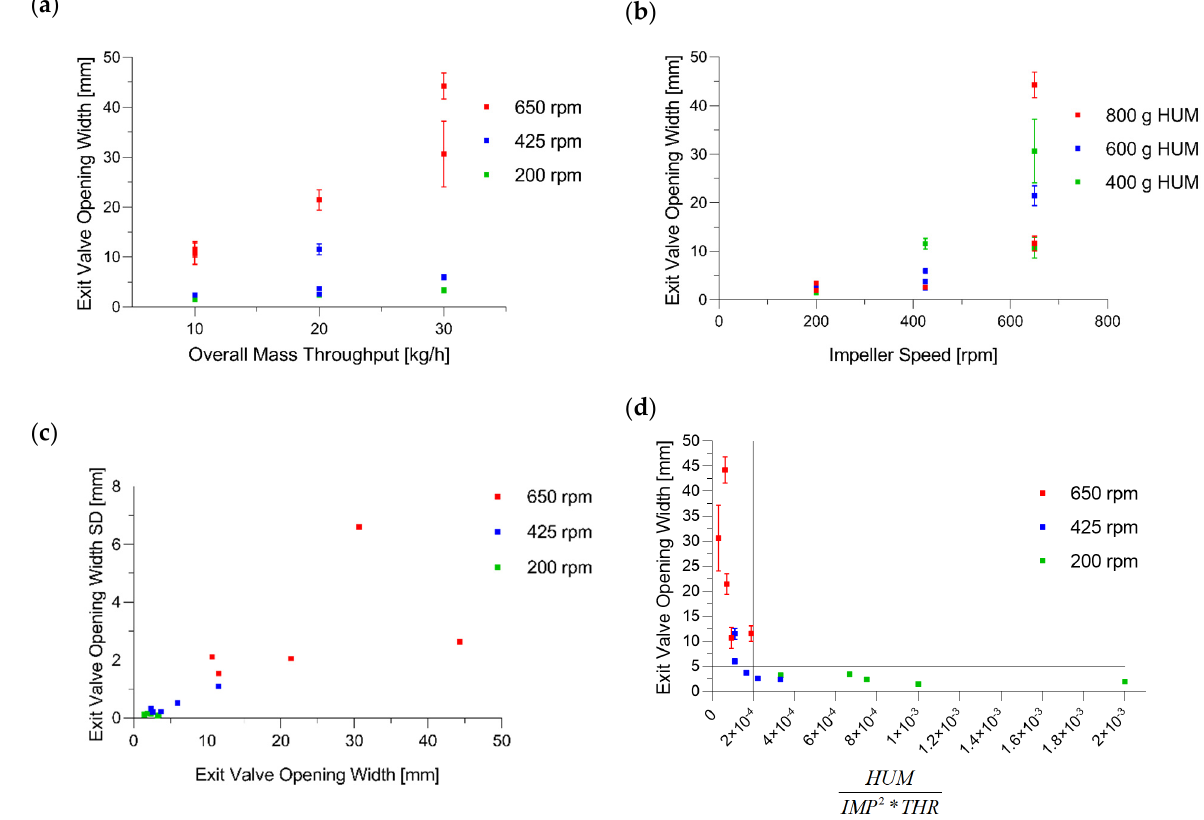
Figure 11. ( a ) Exit valve opening width vs. throughput (kg/h) in relation to varying impeller speeds. ( b ) EV in dependence of impeller speed. ( c ) EV SD vs. EV. ( d ) EV as function of HUM where x-values higher than 2 × 10 − 4 result in EV below 5 mm.